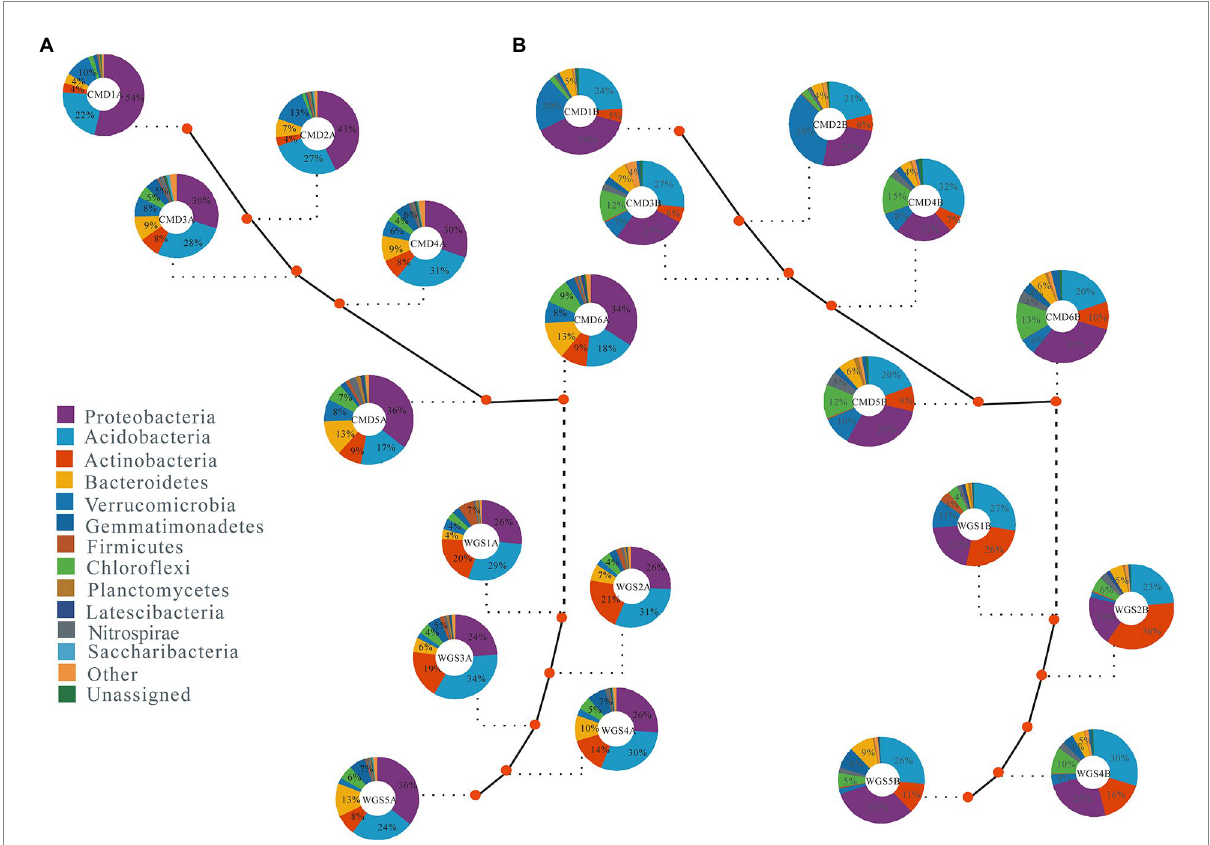
FIGURE 1 The mean relative abundance ( ≥ 0.1%) of dominant soil bacterial phyla in karst graben basin of Yunnan-Kweichow Plateau (A) indicating A layer and (B) indicating B layer. The mean relative abundance less than 0.1% were classified into